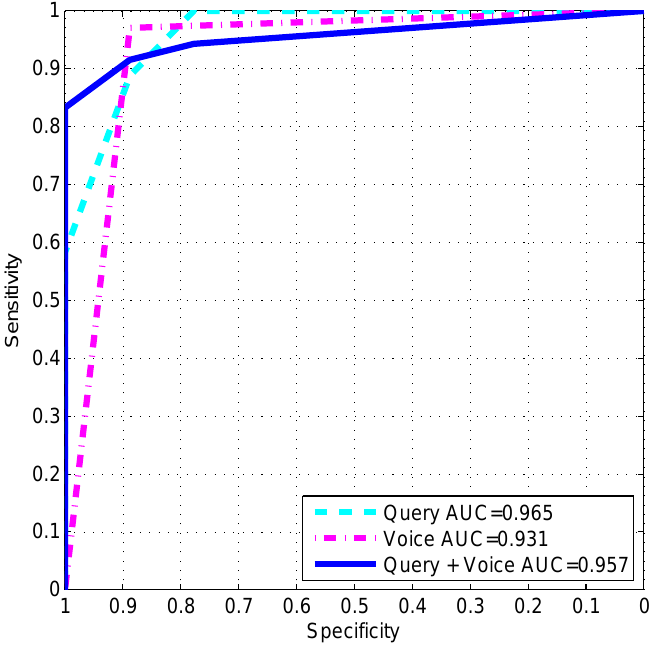
Figure 4. ROC (Receiver operating characteristic) curves and AUC (Area under the curve) for unseen voice and query